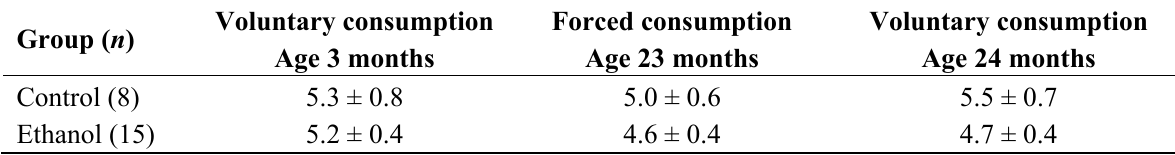
Table 1. Consumption of ethanol (g/kg/day) during different phases of the